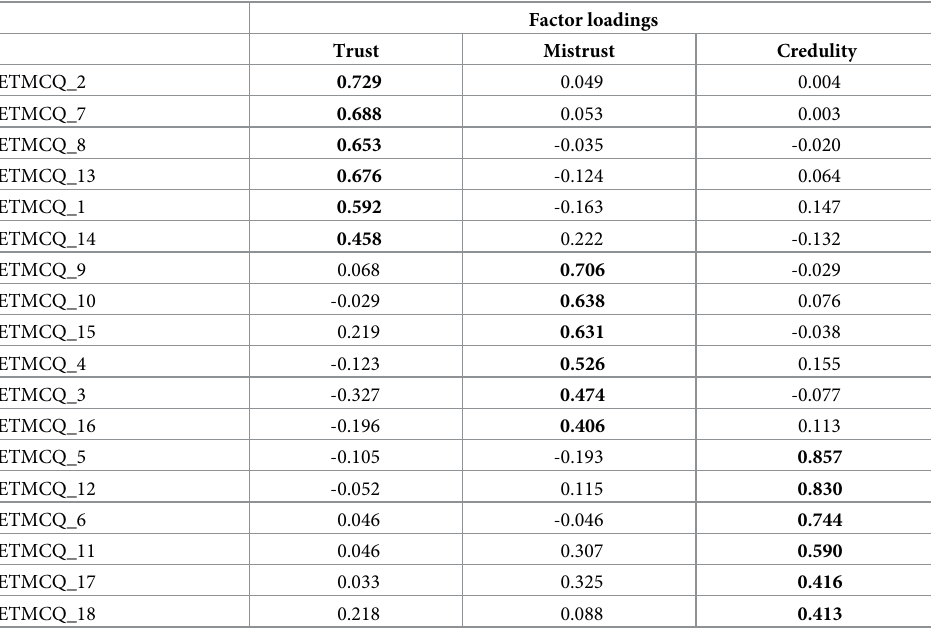
Table 2. Results of the exploratory factor analysis (Study 1; discovery sample n = 250).